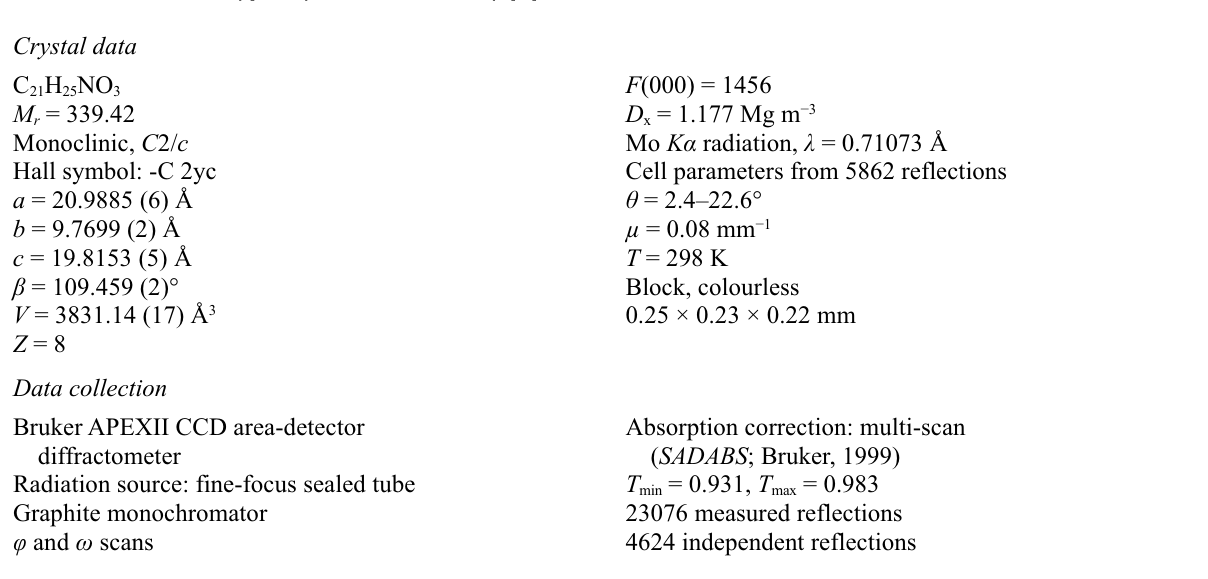
Packing of molecules along the b axis.